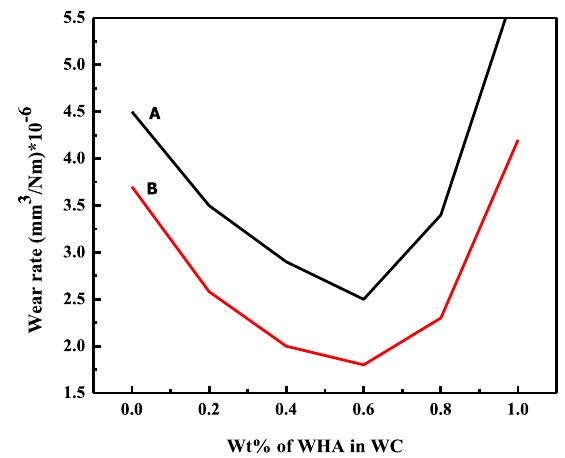
Fig. 6 Wear rate of C m C during wear experiment conducted at 2 N applied load and 300 m sliding distance at room temperature in A dry and B wet condition